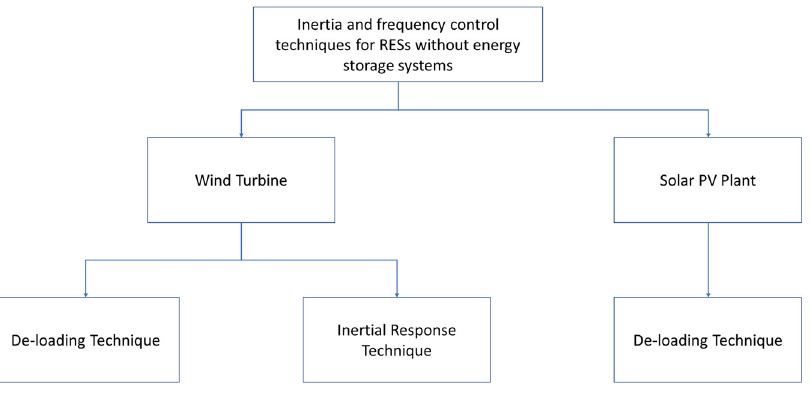
Figure 7. Frequency control techniques for variable renewable energy solutions [70].